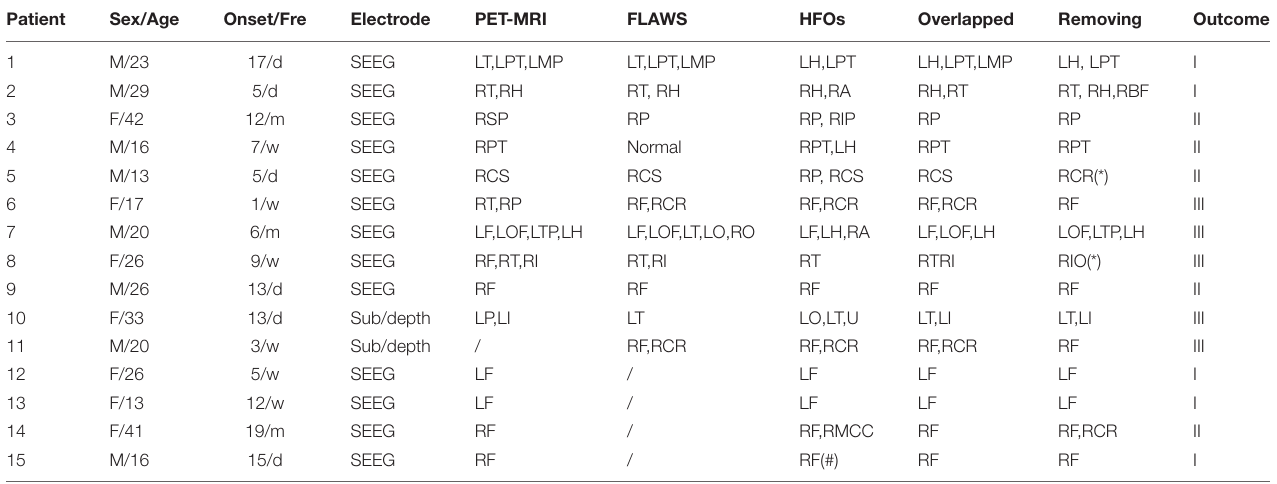
TABLE 1 | Clinical information for all